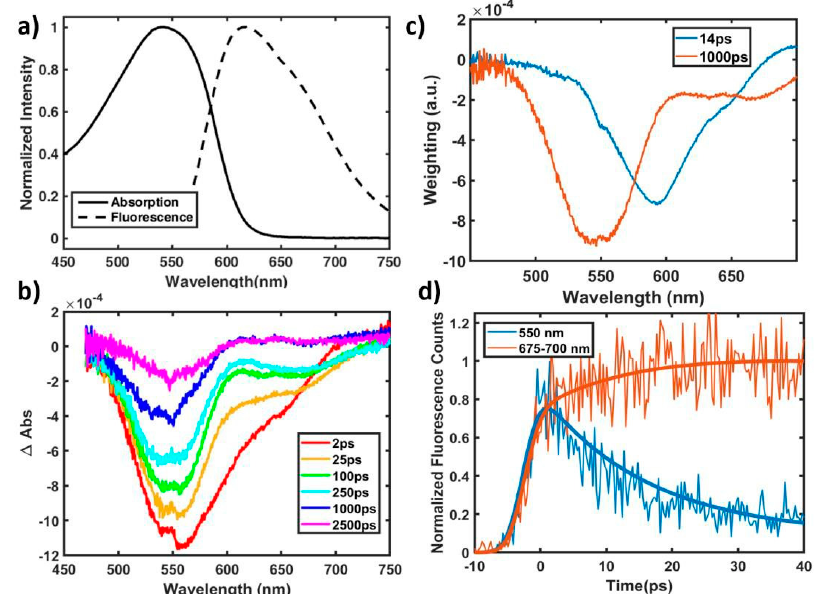
Figure 3. a ) Normalized absorption and fluorescence spectra of n = 2 oligomer. b ) TA spectra of n = 2